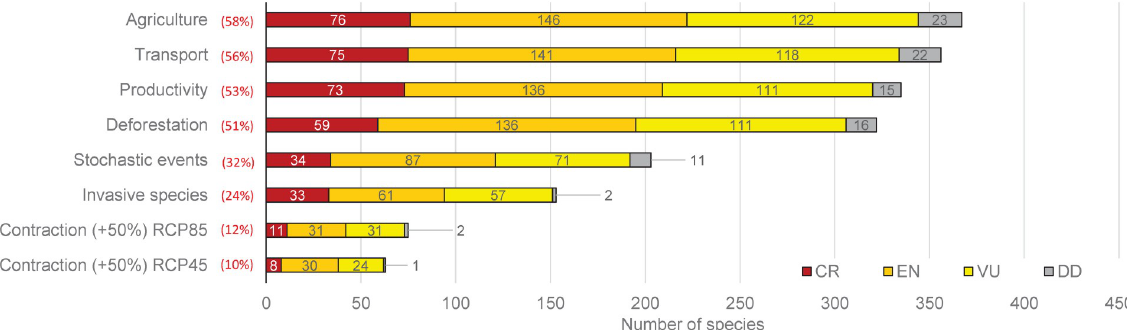
PLOS ONE | https://doi.org/10.1371/journal.pone.0251027 May 6,